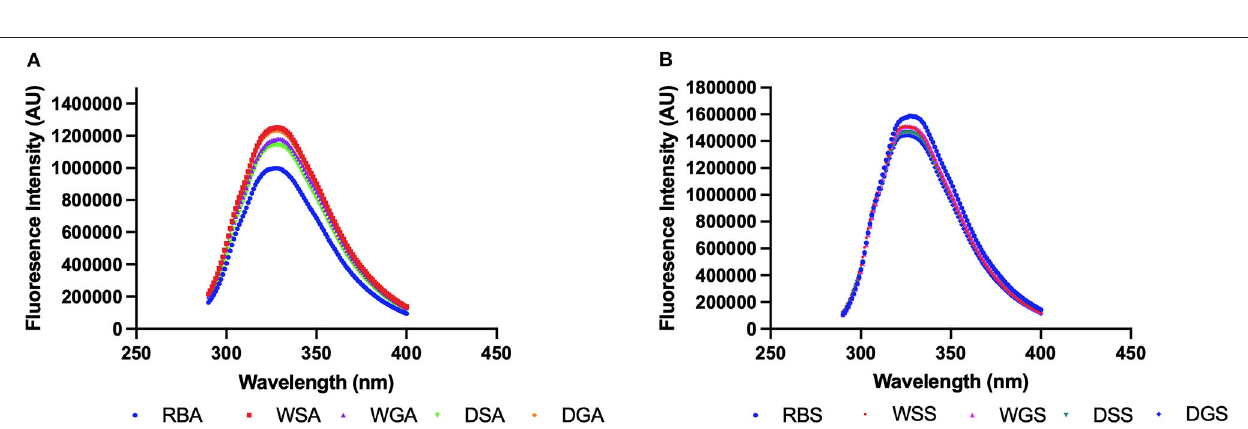
FIGURE 3 | Sodium dodecyl sulfate-polyacrylamide gel electrophoresis profiles of Yellow Eye bean proteins extracted using salt- (A) and alkaline-extraction (B) techniques. Molecular distribution was compared to a New England BioLabs Precision Plus pre-stained protein marker (P77066, 10–250 kDa) in lane 1. The samples were separated using a 12% mini-Protean precast gel stained with Coomassie Brilliant Blue (0.1%).